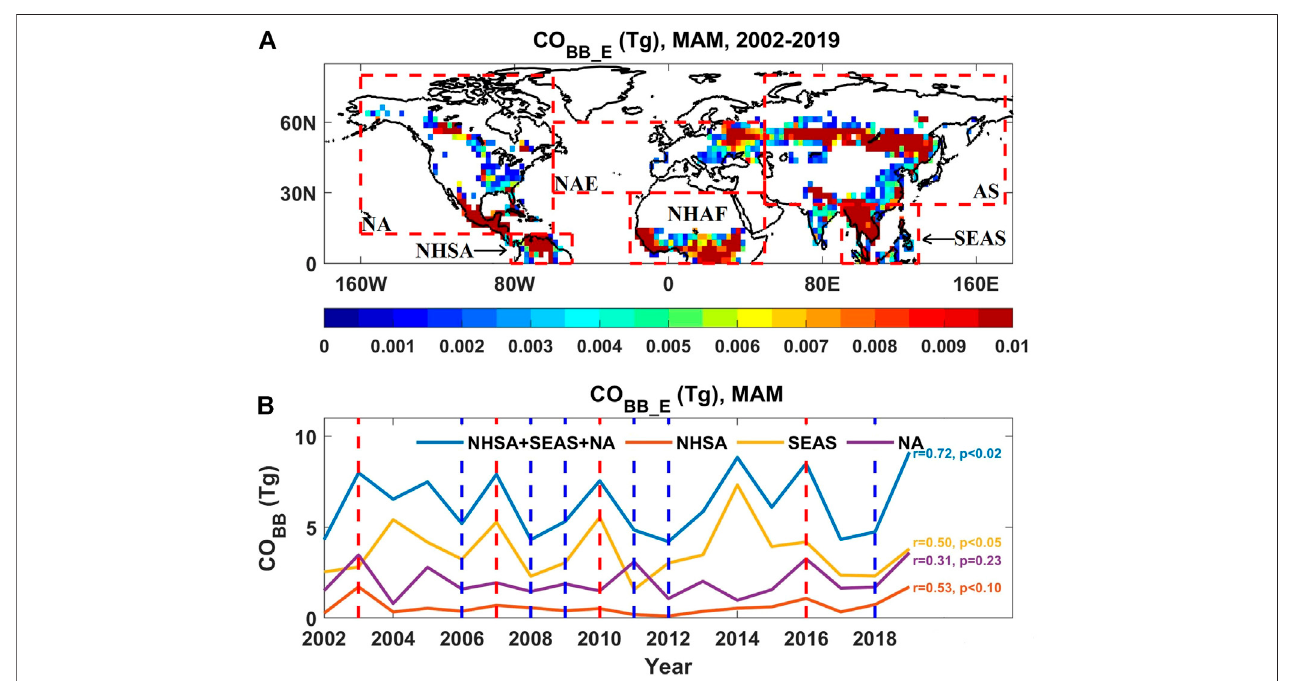
FIGURE4|(A) SpatialdistributionofMAMCOemissionsfrombiomassburning(CO BB_E ,inTg)averagedover2002 – 2019,basedonGFED4.1sdata.CO BB_E less than 0.001 Tg are not shown. (B) Time series of CO BB_E in MAM from North America (NA), Northern Hemispheric South America (NHSA), and Southeast Asia (SEAS) over 2002 – 2019. The correlation coef fi cients ( r ) and the corresponding p -values ( p ) between the ENSO index and CO BB_E are indicated. The vertical red and blue lines show El Niño and La Niña years